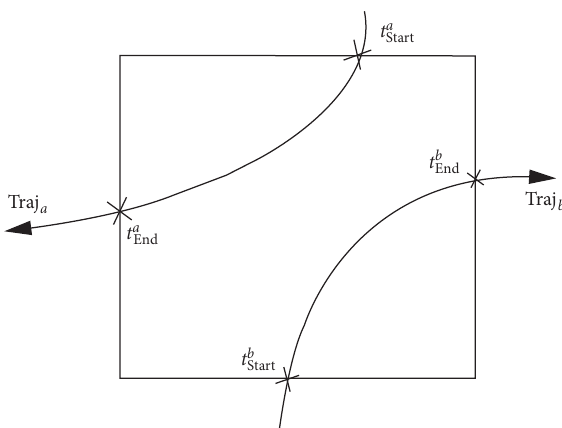
Figure 2: Diagram of space-time constraints during the encounter